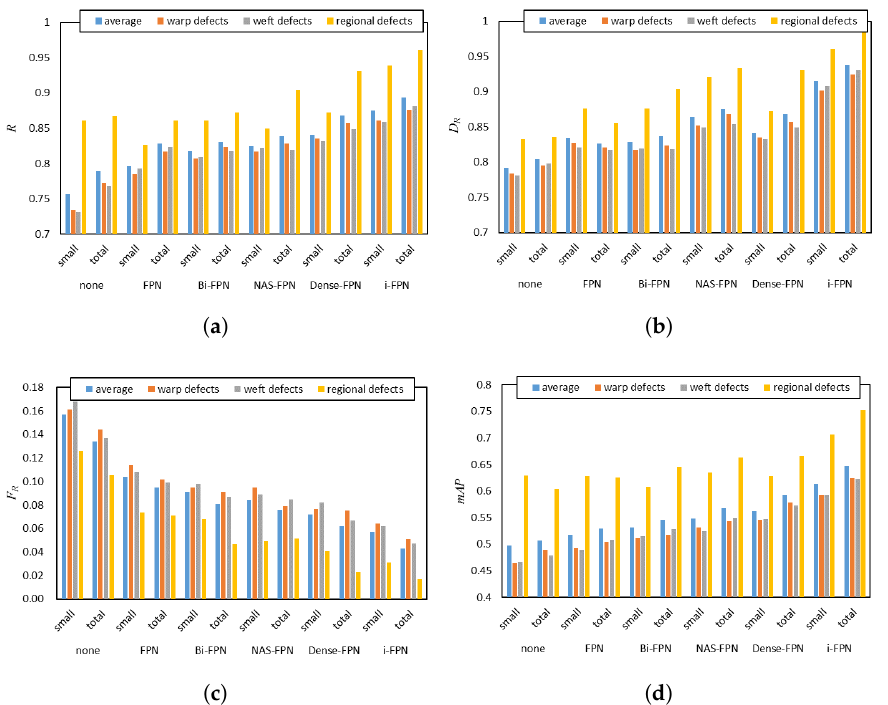
Figure 14. Performance comparison between different design choices of cross-scale connection on different type of defects. ( a ) Comparison of recall of different methods; ( b ) Comparison of Detection Rate of different methods; ( c ) Comparison of False-alarm Rate of different methods; ( d ) Comparison of mAP of different methods